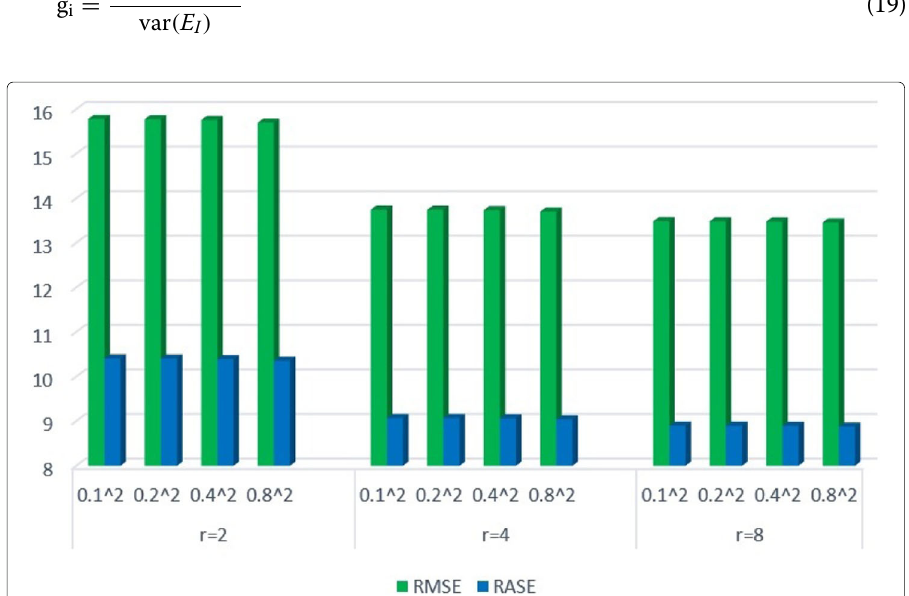
The total semantic map D Total is injected into the upsampled MS image through injection gains g i which are adjusted by (19).